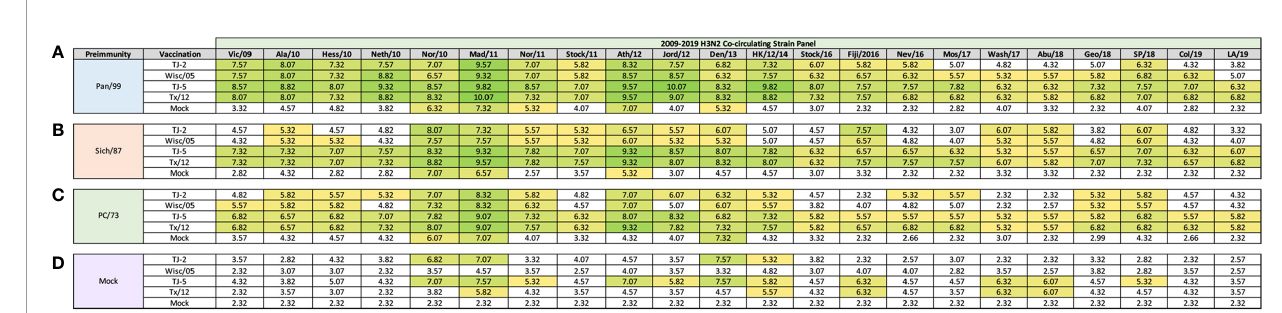
FIGURE 7 | Day 182 H3N2 Co-circulating Strain HAI Panel. Serum collected from animals 182 days post infection (14 days after second vaccination) was analyzed for HAI activity against a panel of co-circulating H3N2 in fl uenza strains spanning 2009-2019. Table is divided into sections based on the virus each animal received to establish preimmunity: A/Panama/2007/1999 (A) , A/Sichuan/2/1987 (B) , A/Port Chalmers/1/1973 (C) , or PBS (Mock) (D) . Cells in table are color coded as a heat map based upon Log(2) HAI geometric mean titer (GMT) for each group of ferrets (N=4). The heat map colors cells yellow at Log(2) GMT of 5.32 which correspond to an HAI titer of 1:40 and cells become a darker shade of green as the average antibody titer of the group increases. Cells with no color correspond to groups that did not achieve a GMT